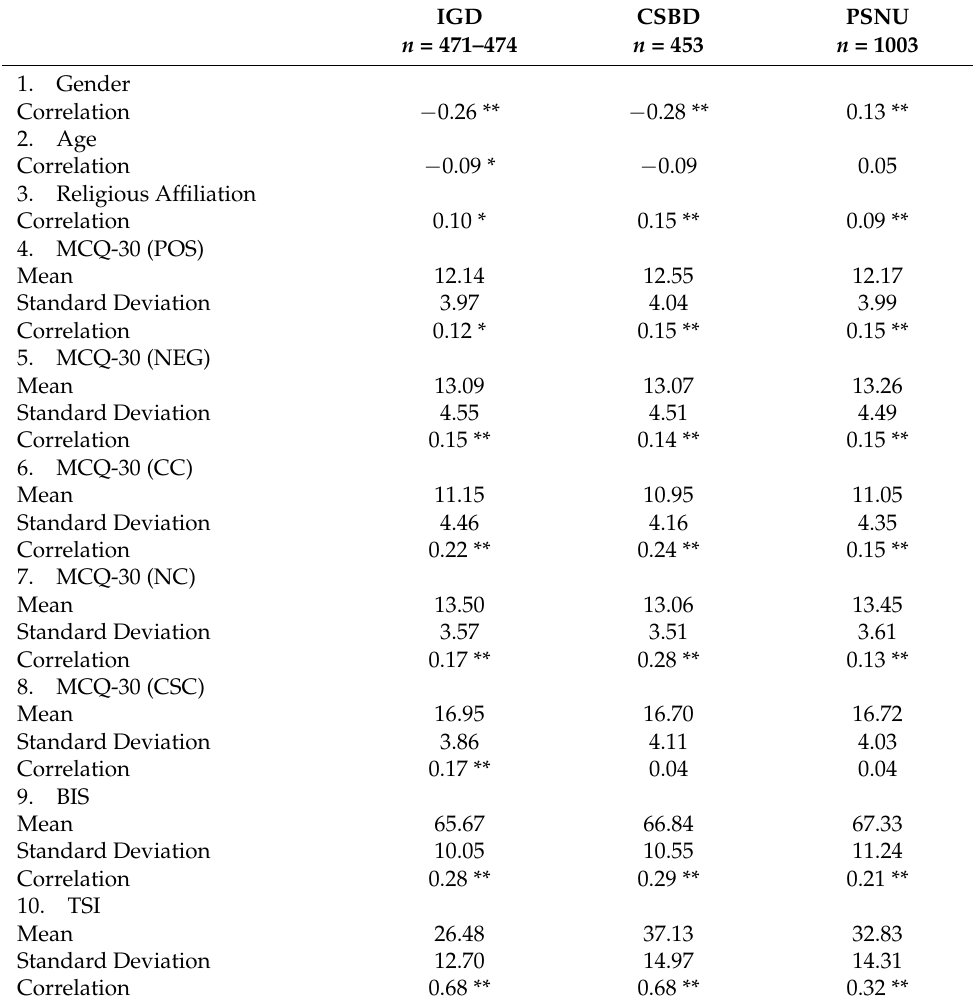
Table 1. Means, standard deviations and bivariate correlations with outcome variables across each